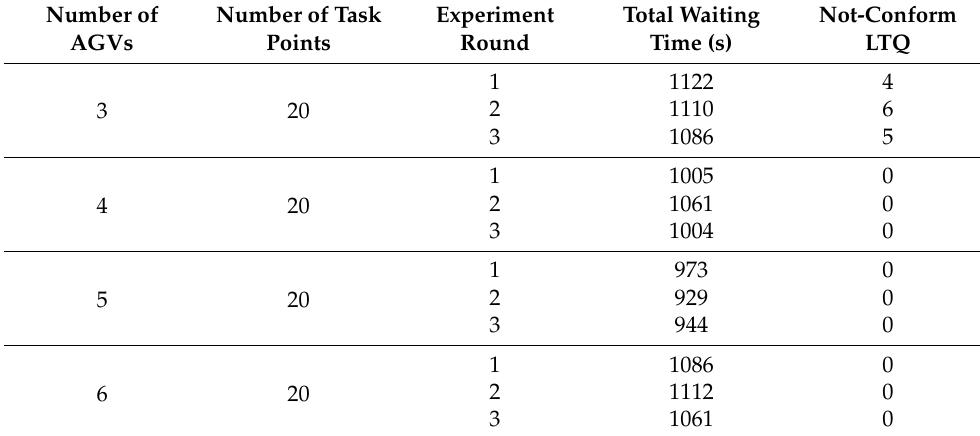
Table 8. The experimental results of different number of AGVs at 20 task points.